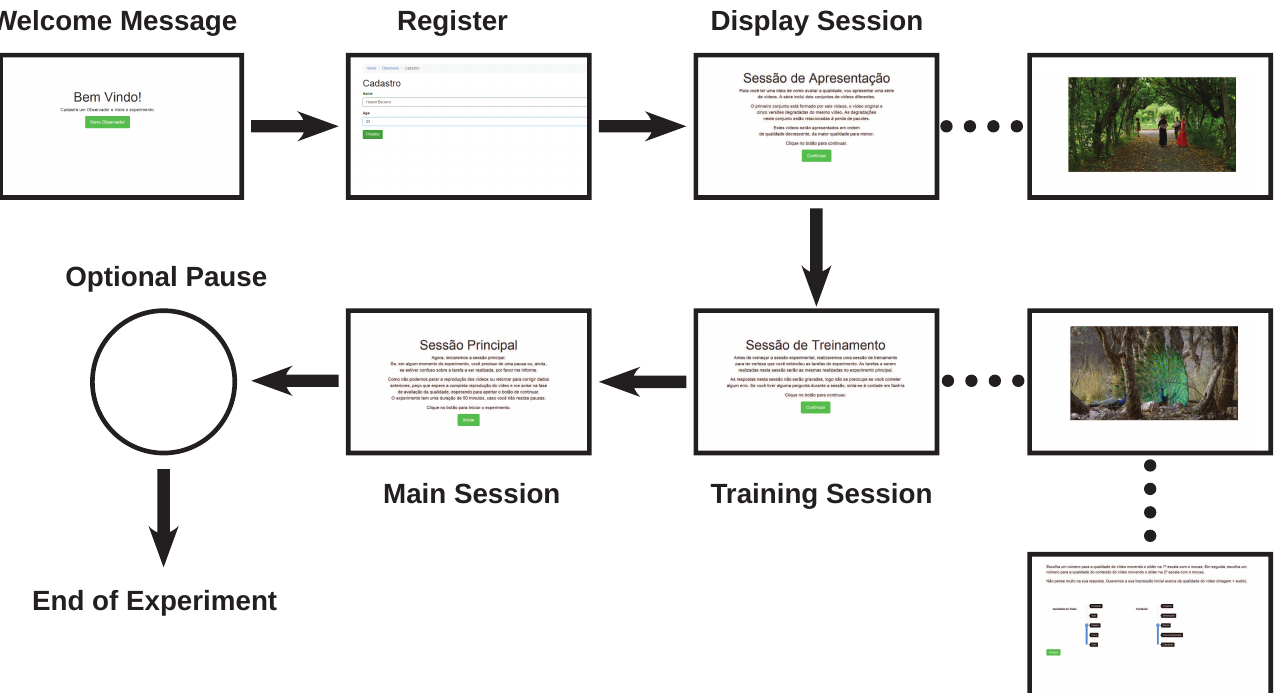
Figure 3. Sub-sessions of the perceptual